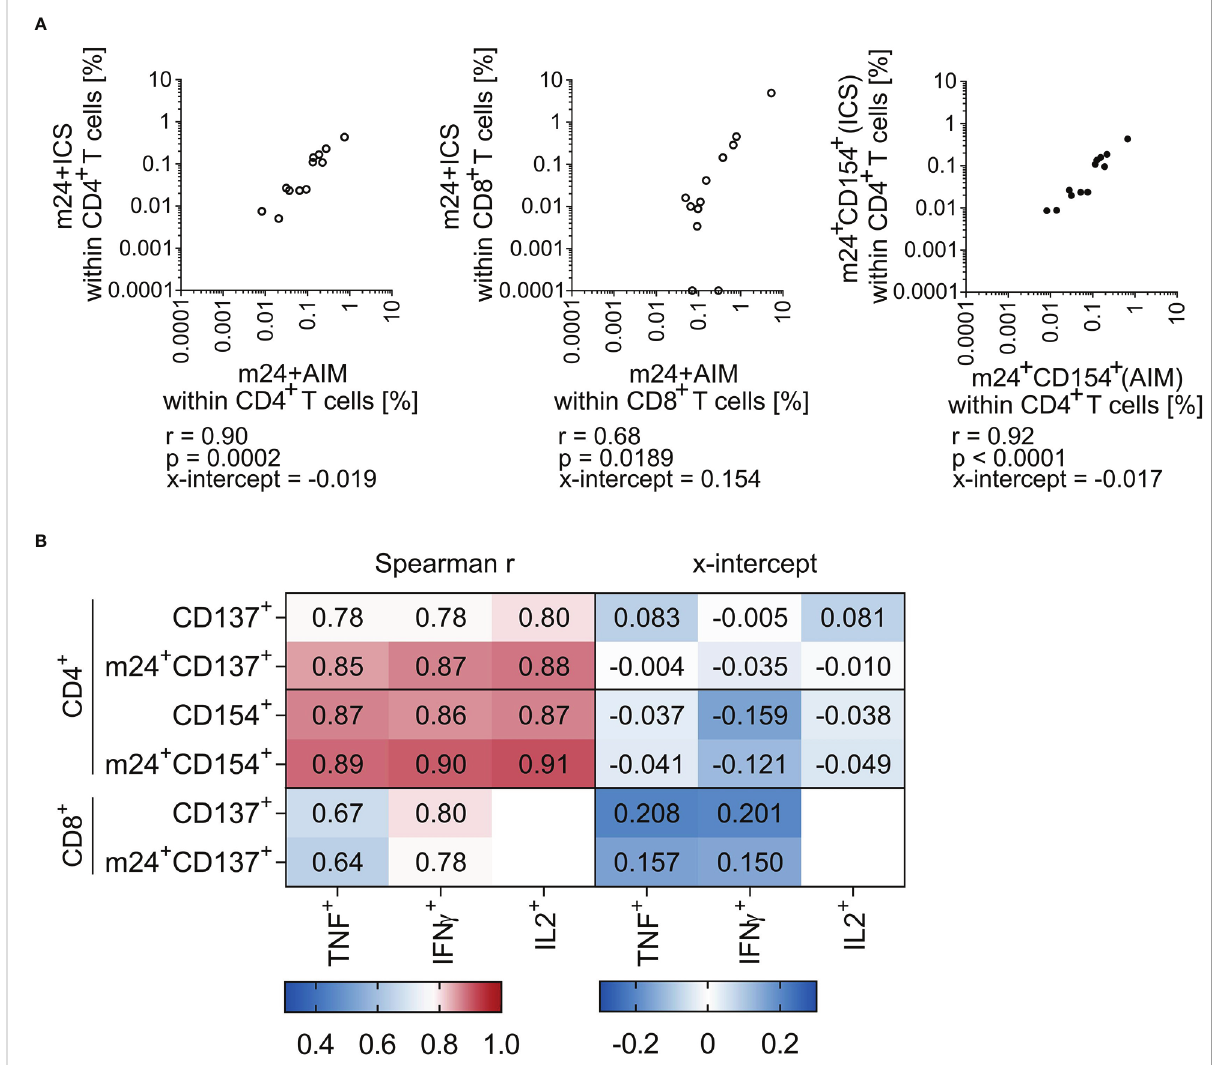
FIGURE 4 Frequencies of antigen-speci fi c T cells assessed by m24+AIM correlate with those detected with m24+ICS. Correlation between antigen- speci fi c T cell frequencies assessed by AIM or ICS in HD PBMCs (n=12 donor/antigen combinations). Spearman r (p<0.05) and x-intercepts are indicated. Frequencies of stimulated samples are background subtracted. Values that were 0 were set to 0.0001. (A) Comparison of frequencies detected with m24+AIM vs m24+ICS (summed frequencies of m24 + and at least one additional marker + after Boolean gating) for CD4 + (left) and CD8 + (middle) T cells. Comparison of extracellular vs intracellular CD154 staining for CD4 + T cells (right). (B) Heat map of Spearman r (left) and x-intercept (right). Frequencies of antigen-speci fi c CD4 + (top) and CD8 + (bottom) T cells detected by single AIMs or in combination with m24 Ab staining were compared to single cytokine expression. Corresponding correlation graphs are shown in Supplementary Figure